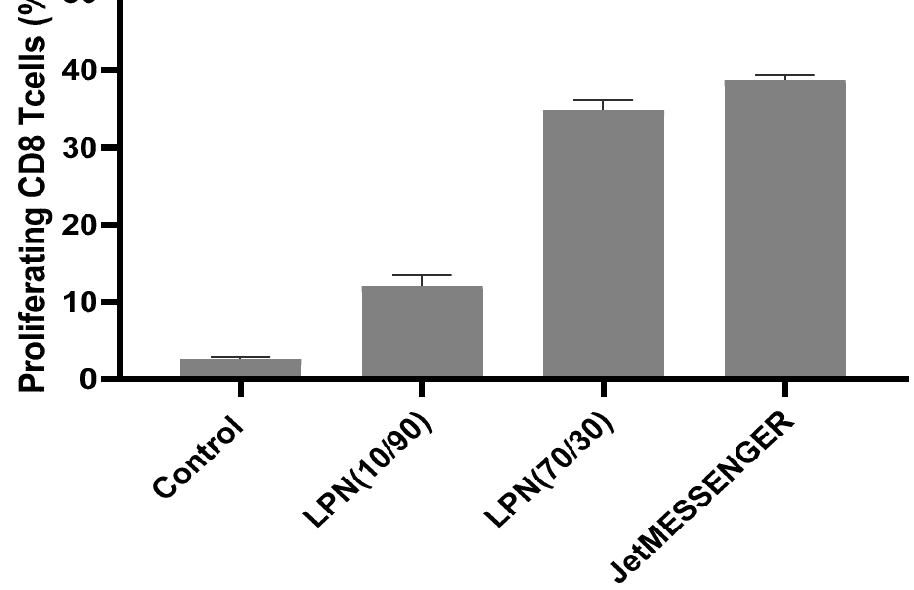
Figure 9. Proliferation of OVA-specific murine CD-8+ T-cells after stimulation by primary DCs. Suc- cessful transfection of DCs with mRNA loaded LPNs promoted effective activation and proliferation of antigen-specific T-cells. mRNA encodes for the model antigen ovalbumin that fits the specificity of the added T-cells. LPN(70/30) with DOPE content of 70% in the lipid layer again outperforms LPN(10/90) with higher DOTMA content.